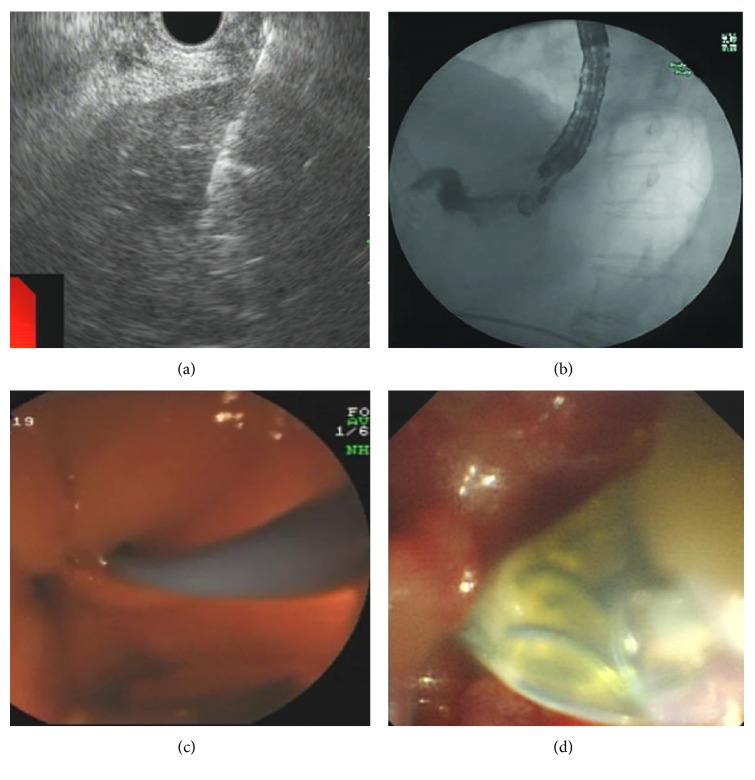
Endoscopic ultrasound-guided hepaticogastrostomy. Under real-time EUS guidance, the dilated intrahepatic bile duct was punctured and a cholangiogram was obtained (a and b). After transmural fistula dilation (c), a fully covered self-expandable metal stent was deployed (d).